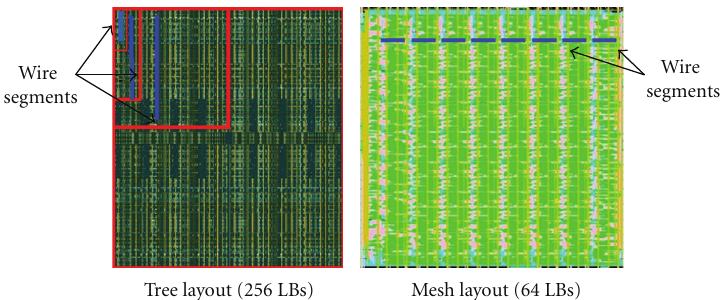
Figure 15: Layout view of Mesh and Tree interconnect structures.